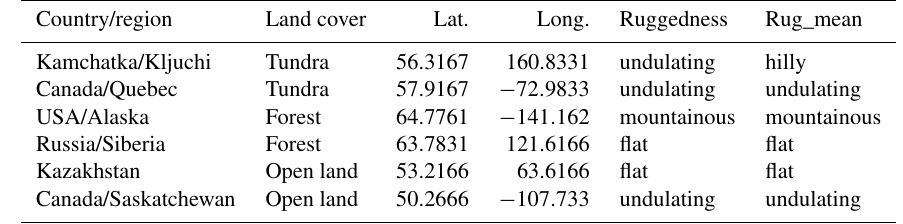
Table 2. Latitude, longitude and land cover of each weather station. (See also Fig. 1.)